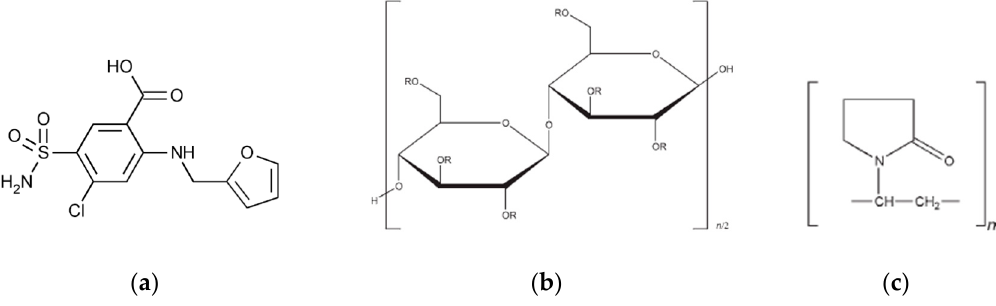
Figure 1. Chemical structure of furosemide ( a ) and the structural units of fiber forming polymers ( b : HPC, c : PVP).